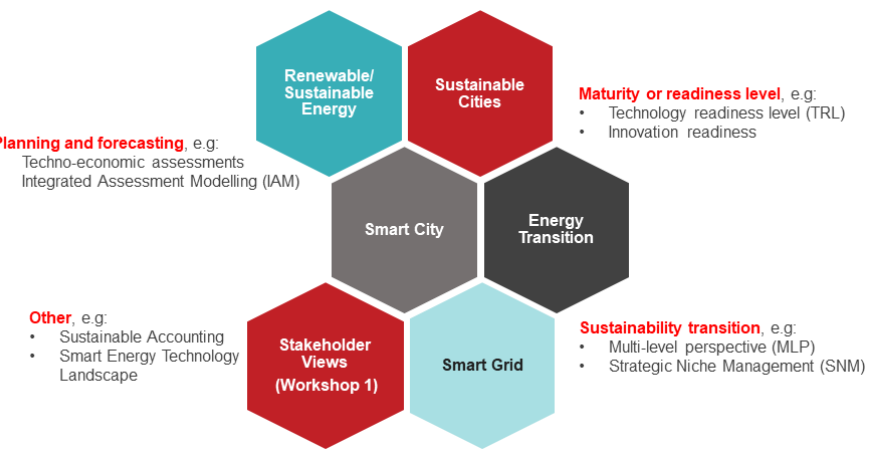
Figure 1. Summary of analytical themes and pathways explored to identify important indicators for assessing Smart Local Energy Systems.